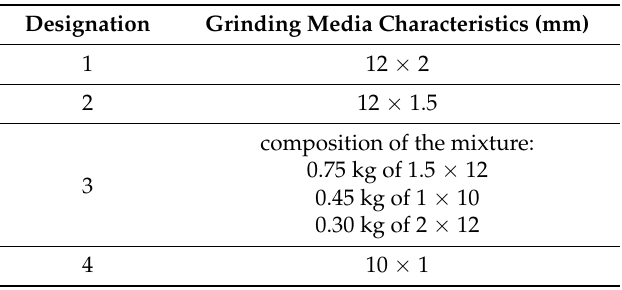
Table 2. Grinding media characteristics, a total weight of each set: 1.5